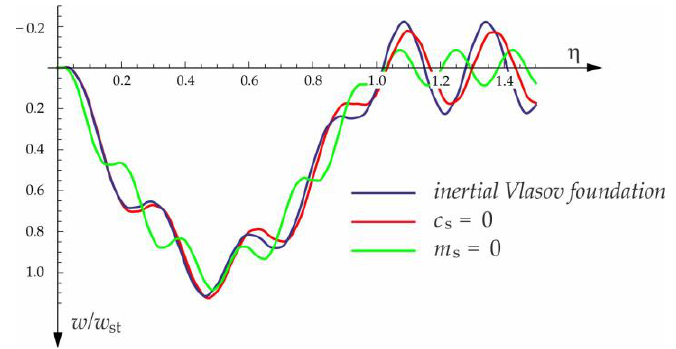
Figure 4. Dynamic deflection of the midpoint of the beam on the foundation subjected to the force moving at v = 50 m/s.